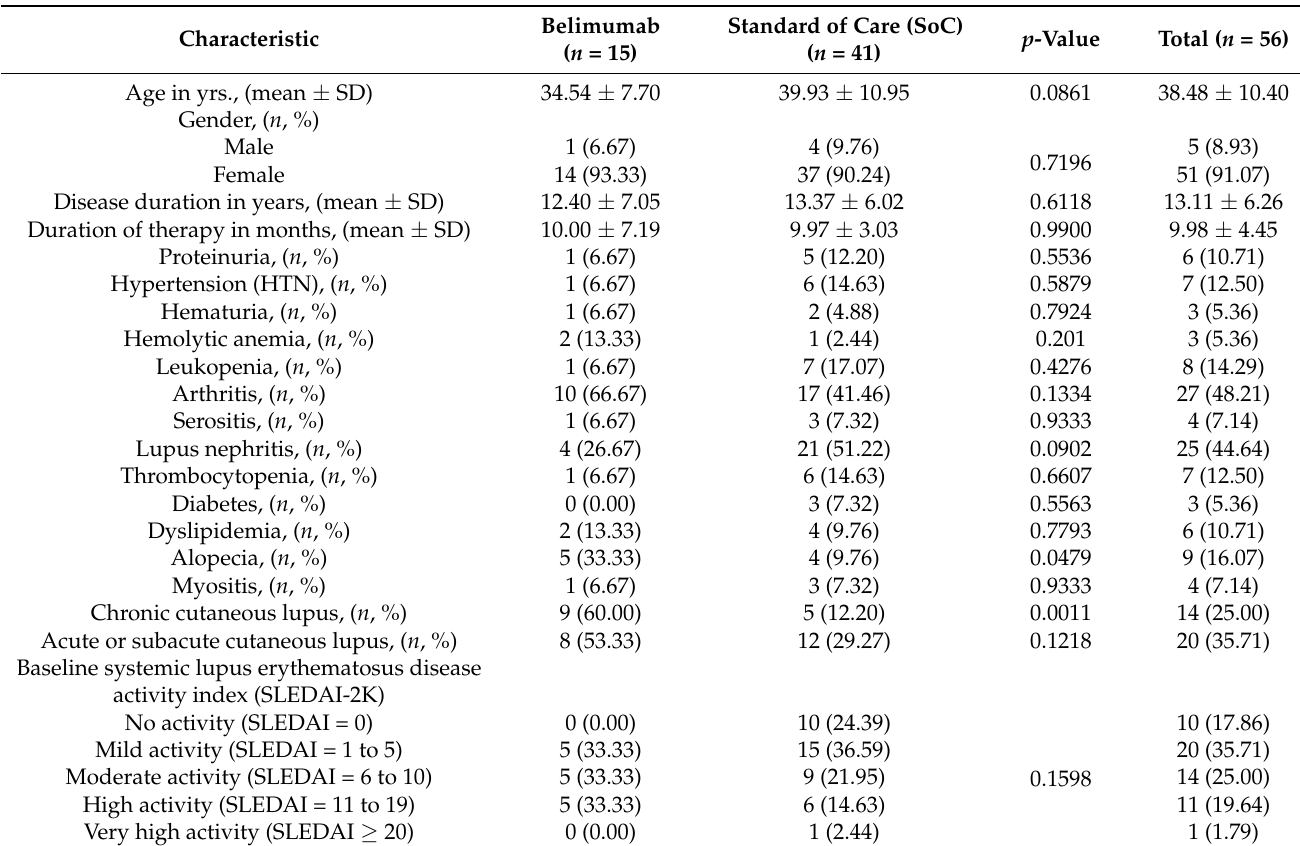
Table 1. Patients’ baseline